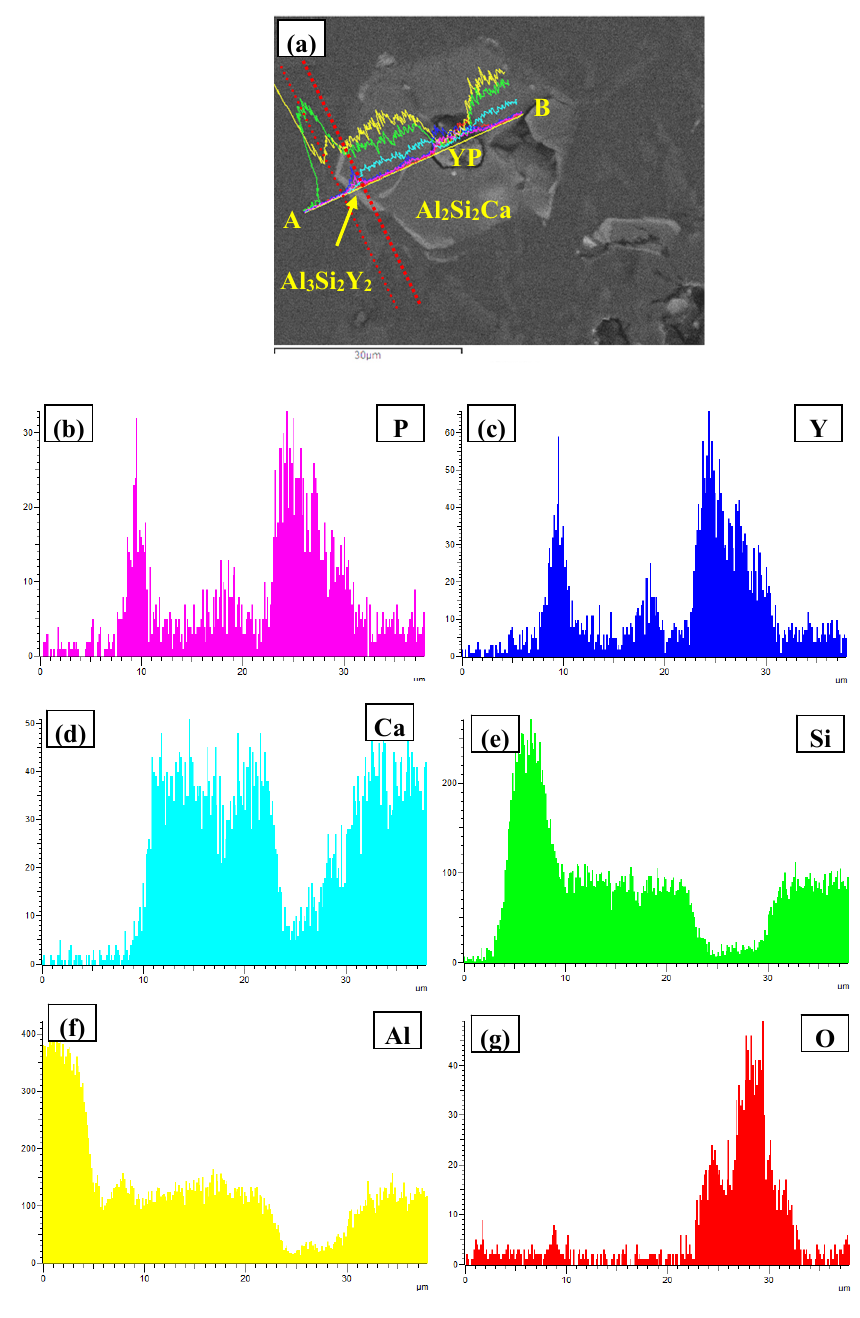
Figure 11. FESEM images of Al–12Si–2Ca–3Y–1P alloys: (a) microstructure; ( b – g ) EDS line scanning alalysises along A and B.